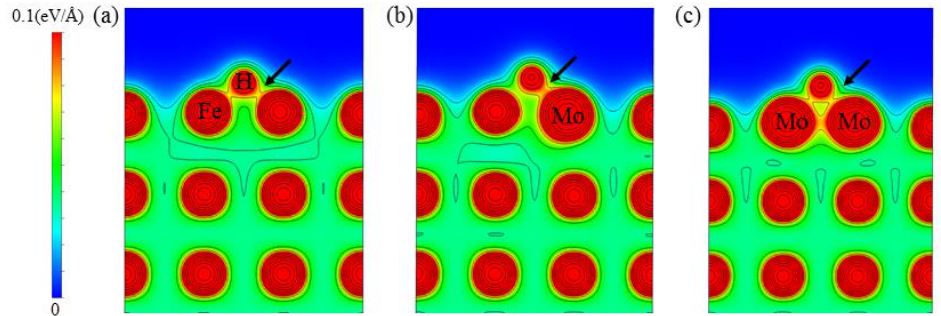
Figure 6. H adsorption charge density map on the (100) surface. ( a ) H adsorption on a pure Fe (100) surface; ( b ) H adsorption on a Mo-doped surface; ( c ) H adsorption on surface doped by two Mo atoms.